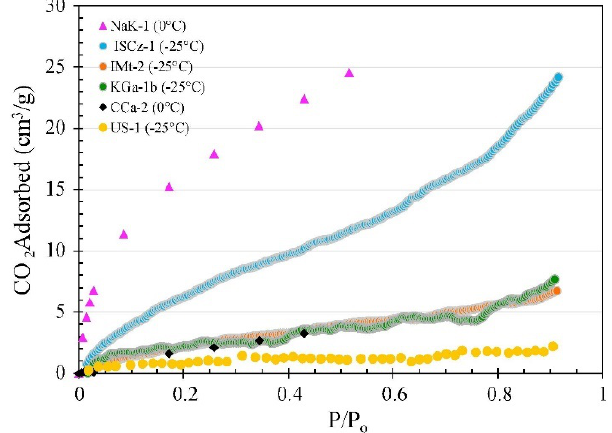
Figure 3. Comparing CO 2 adsorption isotherms for the US-1 shale sample to the various clay (mixed layer illite-smectite (ISCz-1), illite (IMt-2), chlorite (CCa-2), and kaolinite (KGa-1b)) and kerogen (NAk-1) components typically found in shale. Note that data for NAk-1 and CCa-2 were collected gravimetrically using a microbalance at − 200 °C. The remaining samples are measured at − 25 °C using a volumetric Sievert apparatus. Reprinted from Sanguinito et al. [50]. Copyright (2018), with permission from